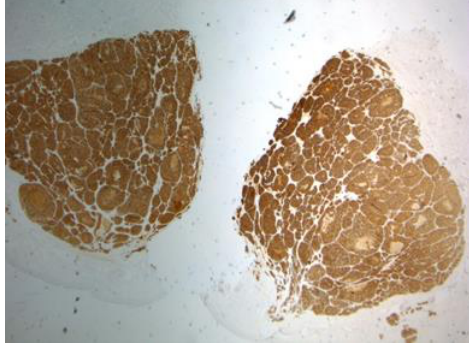
Figure 1. CK20 staining of a case of MMC.